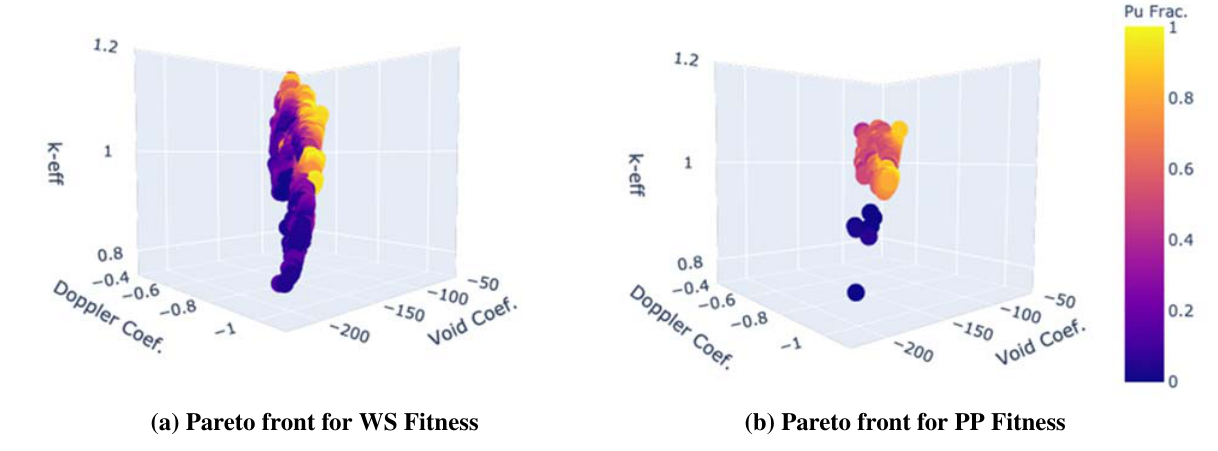
Figure 7: Pareto fronts for